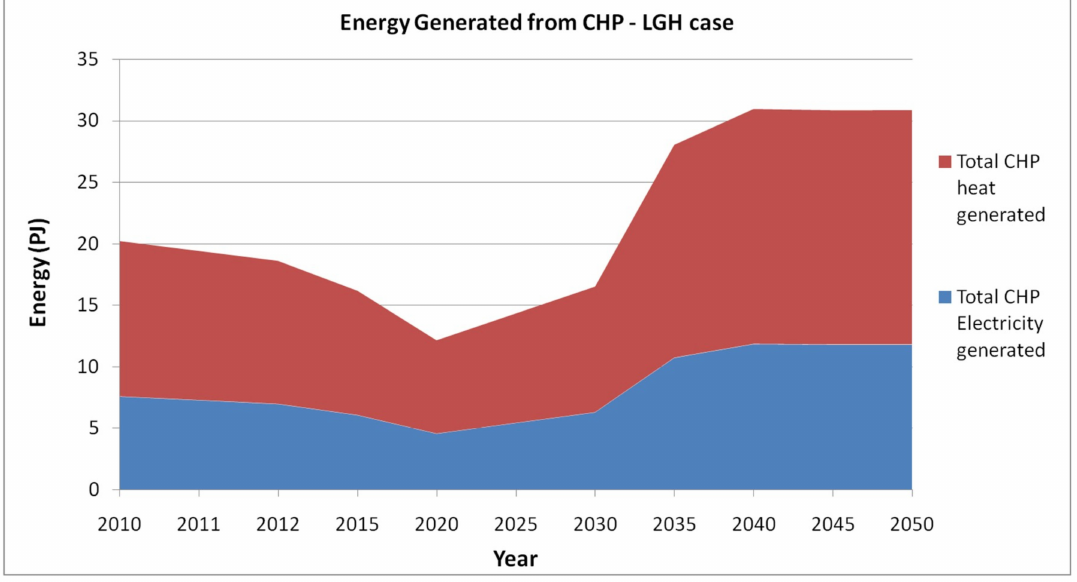
Figure 11. Energy generated from CHP through the use of natural gas and